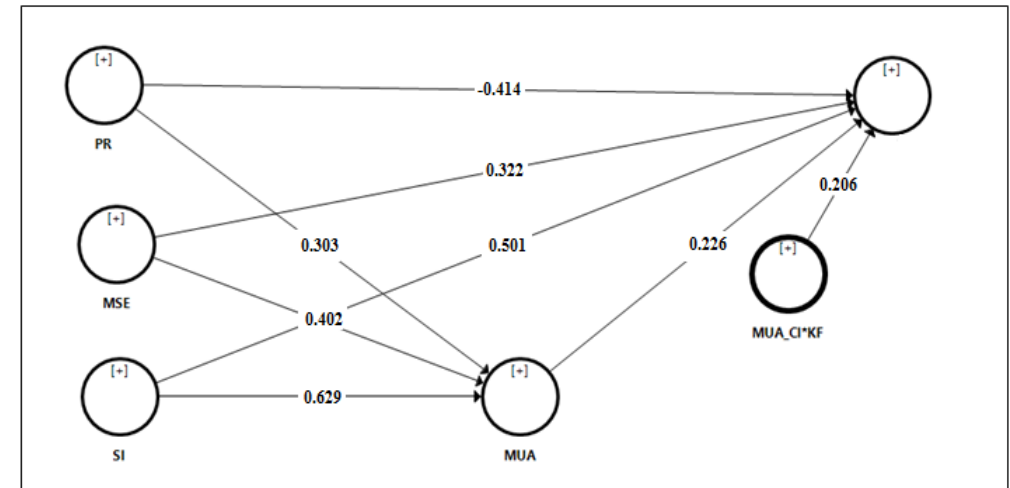
Fig. 3. Hypotheses Testing